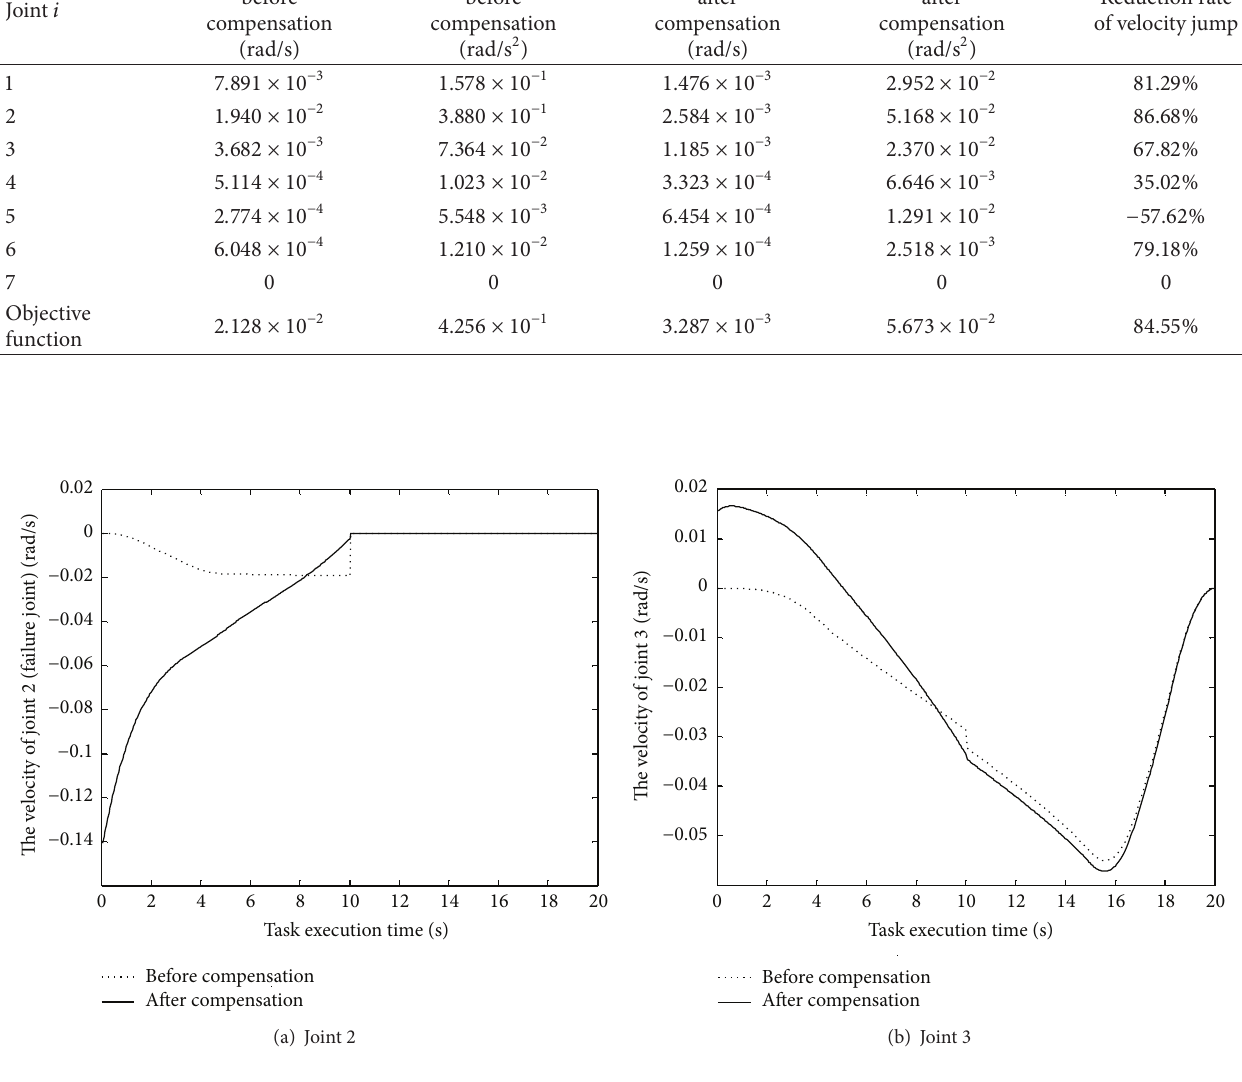
Figure 6: Joint velocity compensated when 𝑐 𝑘 = 0.25